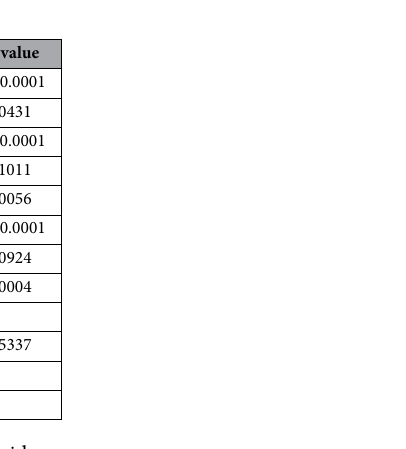
Table 9. The ANOVA table for effectiveness of TiO 2 nanofluid.